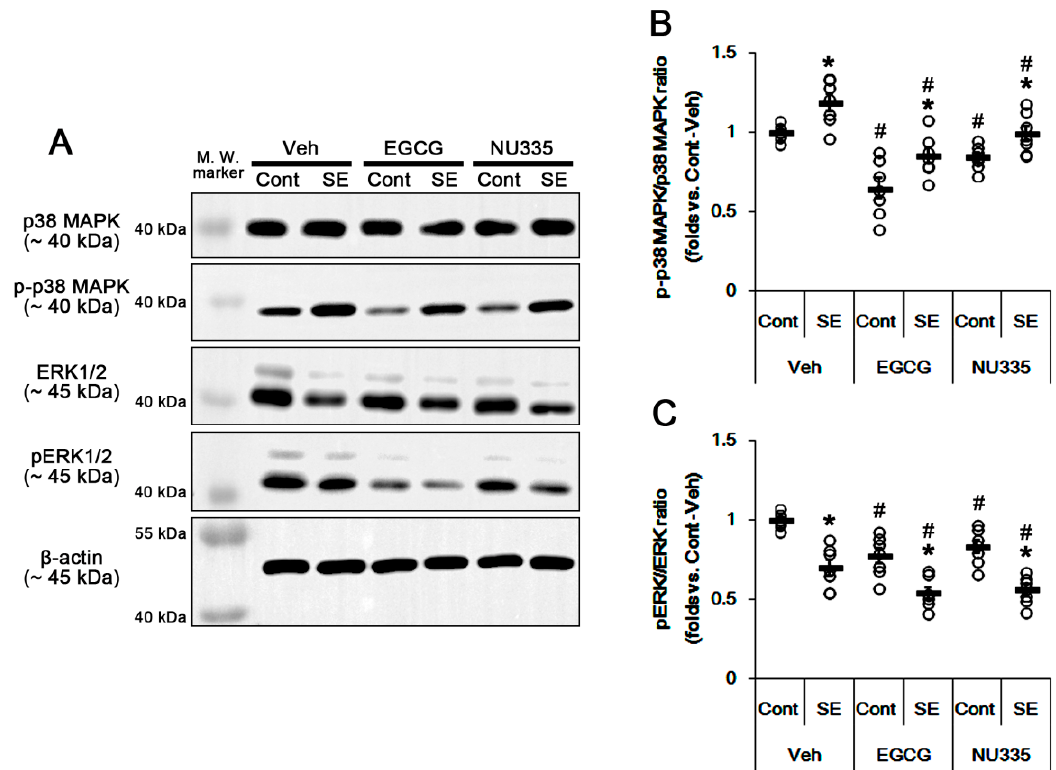
Figure 4. Effects of EGCG and NU335 on p38 mitogen-activated protein kinase (p38 MAPK) and extracellular signal-regulated kinase (ERK) activities in the PC under physiological and post-SE conditions. SE increases p38 MAPK, but not ERK1/2, activity in the PC. EGCG and NU335 decrease p38 MAPK and ERK activities under physiological and post-SE conditions. ( A ) Representative Western blot images for p38 MAPK, p-p38 MAPK, ERK1/2, and pERK1/2 in the PC. ( B , C ) Quantitative values of the effect of EGCG and NU335 on p38 MAPK ( B ) and ERK1/2 phosphorylation levels in the PC ( n = 7, respectively). Open circles indicate each individual value. Horizontal bars indicate the mean value. Error bars indicate S.E.M. Significant differences are * ,# p < 0.05 vs. control (non-SE) animals and vehicle-treated animals, respectively.